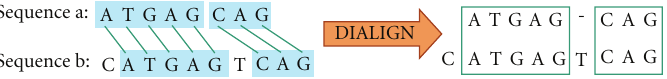
Figure 11: Alignment of two sequences a and b with DIALIGN.